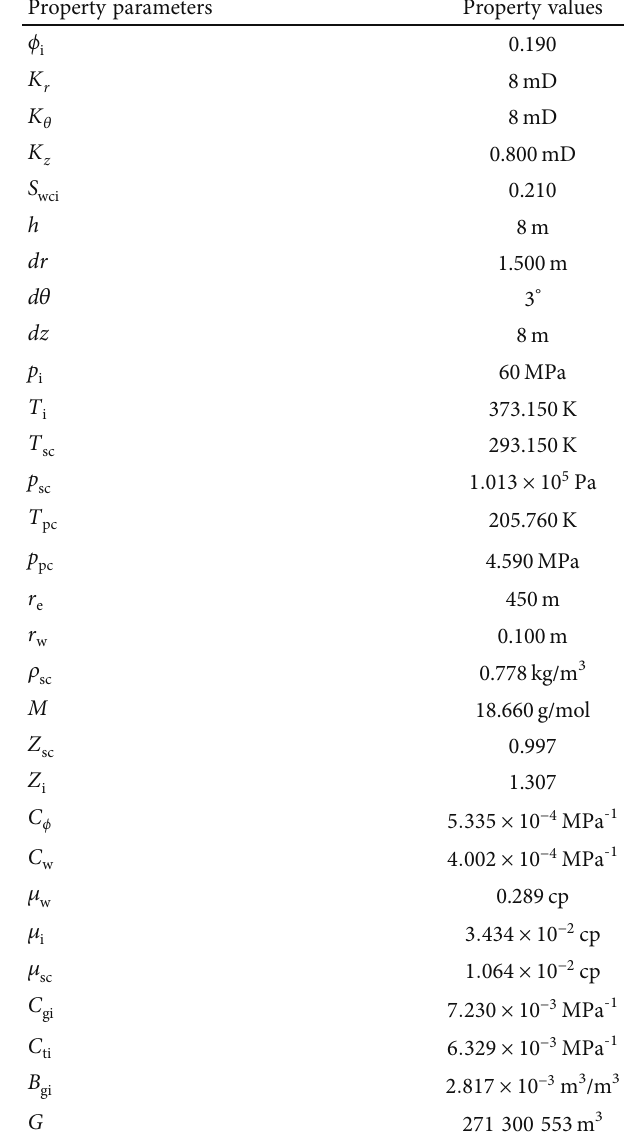
Table 1: Property parameters for numerical simulations. Property